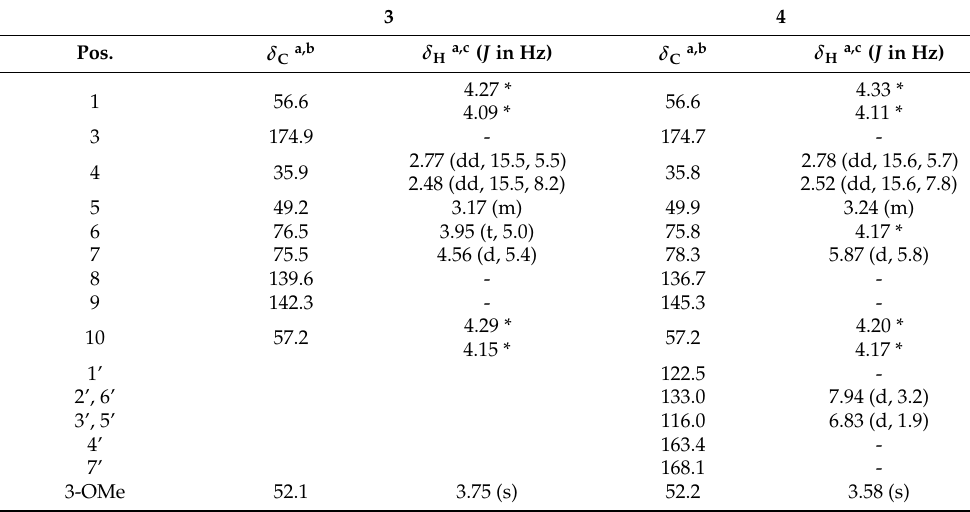
Table 2. NMR spectroscopic data for compounds 3 and 4